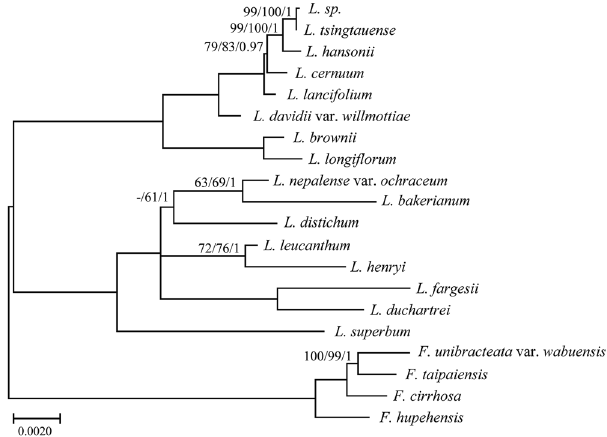
Figure 5. Phylogeny of the 16 Lilium species constructed using 10 regions of highly variable sequences. Fritillaria was used as the outgroup. Numbers above nodes are support values with MP bootstrap values on the left, ML bootstrap values in the middle, and Bayesian posterior probabilities (PP) values on the